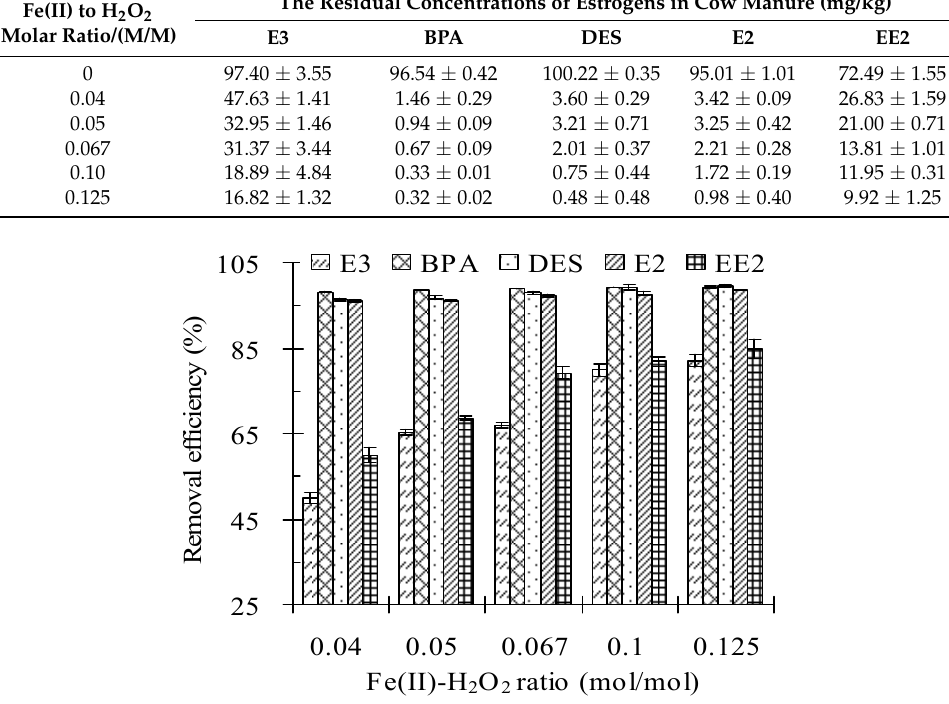
Table 3. Effect of the Fe(II) to H 2 O 2 molar ratio on the residual concentrations of estrogens in cow manure by the Fenton oxidation process. Note: the H 2 O 2 dosage was 2.56 mmol/g; the solid to water mass ratio was 2 g/mL; the initial pH value was 3.0; the reaction time was 24 h. Fe(II) to H 2 O 2 Molar Ratio/(M/M)